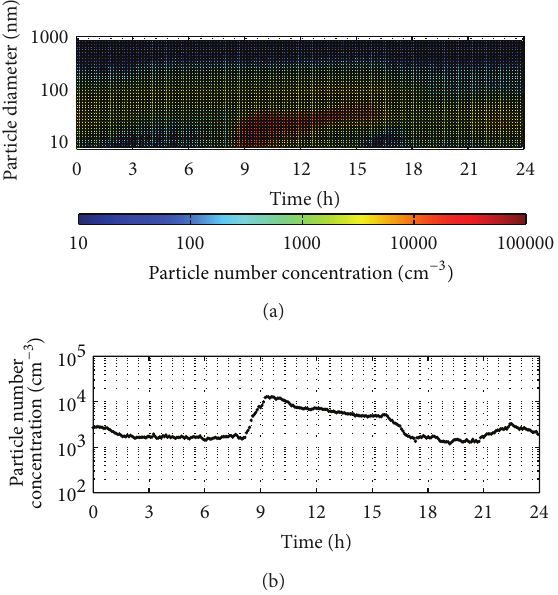
Figure 7: Contour plot of new particle formation and growth on 24 May 2011; colour represents logarithm of concentration in cm −3 .